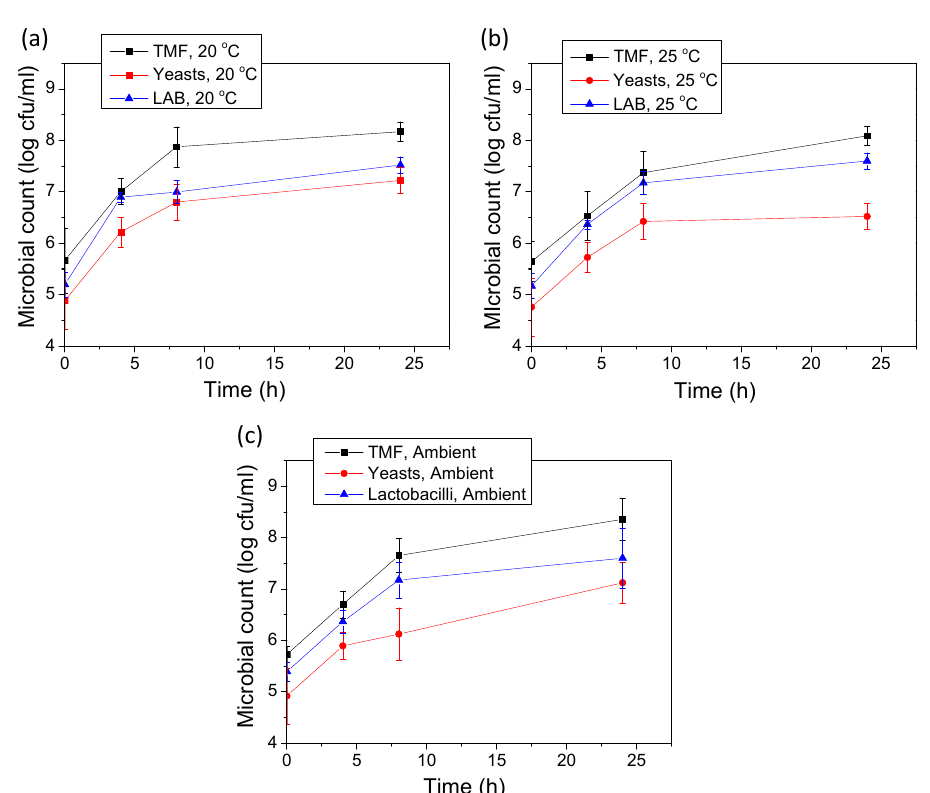
Figure 3. Microbial count for total mesophilic flora (TMF), yeasts and lactic acid bacteria (LAB) during the 24 h fermentation of milk with kefir grains at 20 ◦ C ( a ), 25 ◦ C ( b ), and ambient temperature ( c